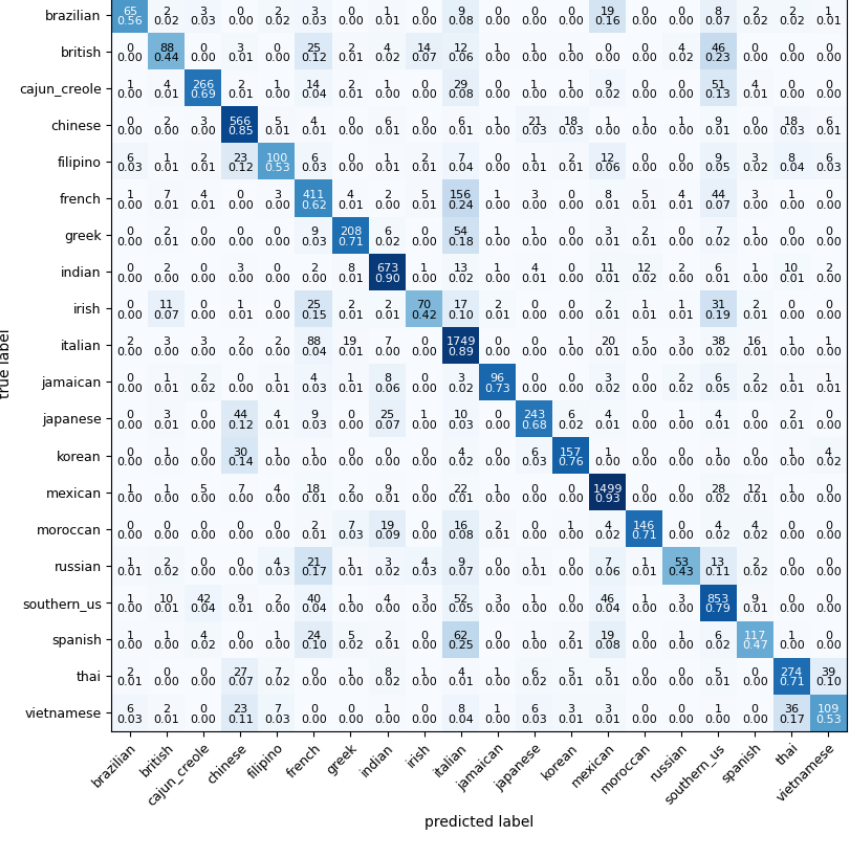
Figure 7. Confusion matrix of the LinearSVC classifier.